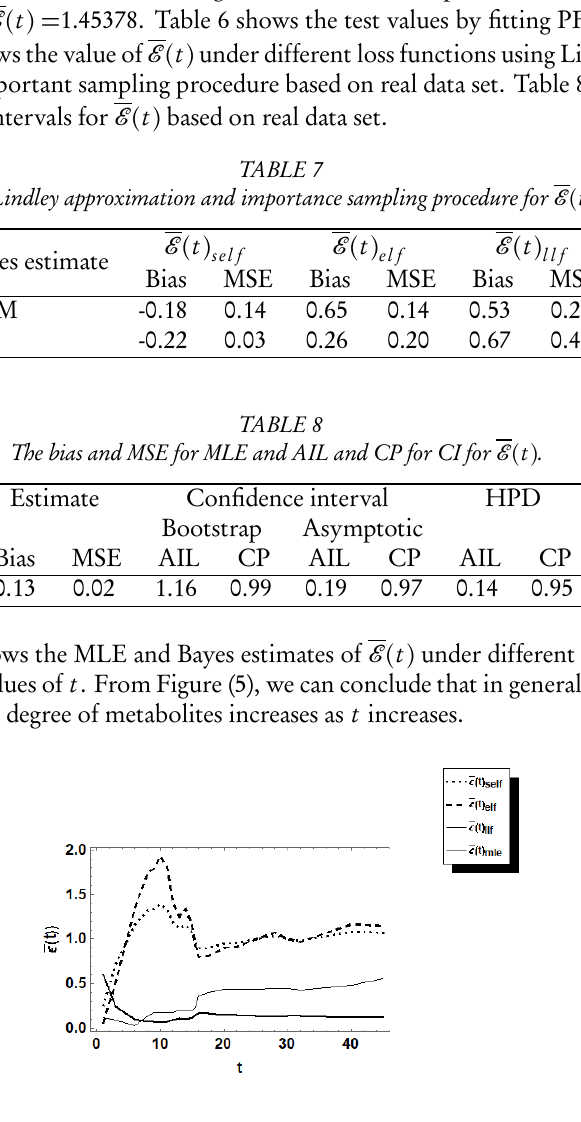
Figure 5 – MLE and Bayes estimates of (cid:69) ( t ) under different loss functions for the real